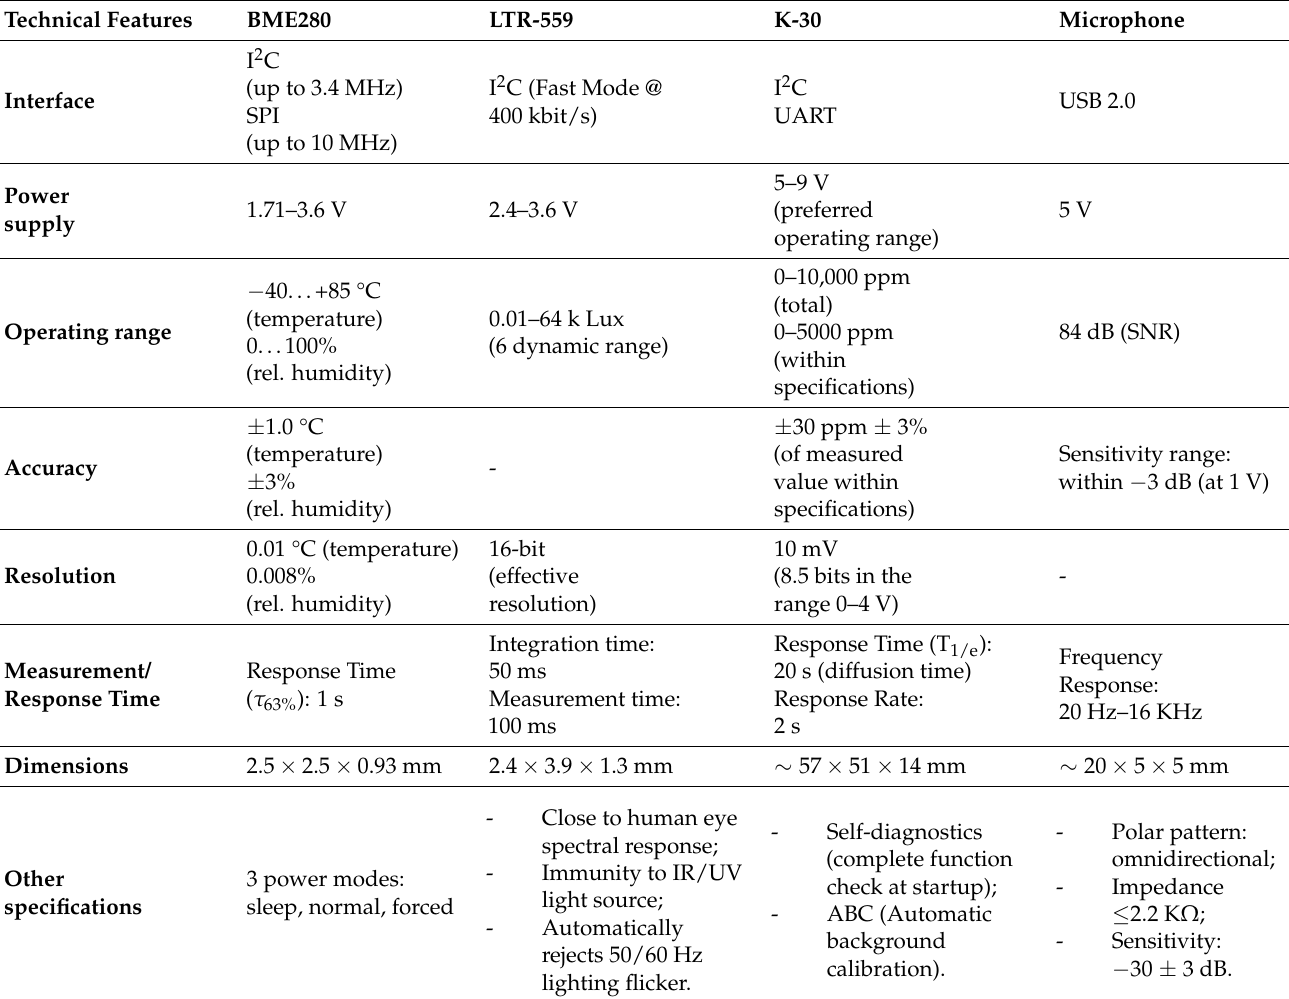
Table 3. Technical features of the